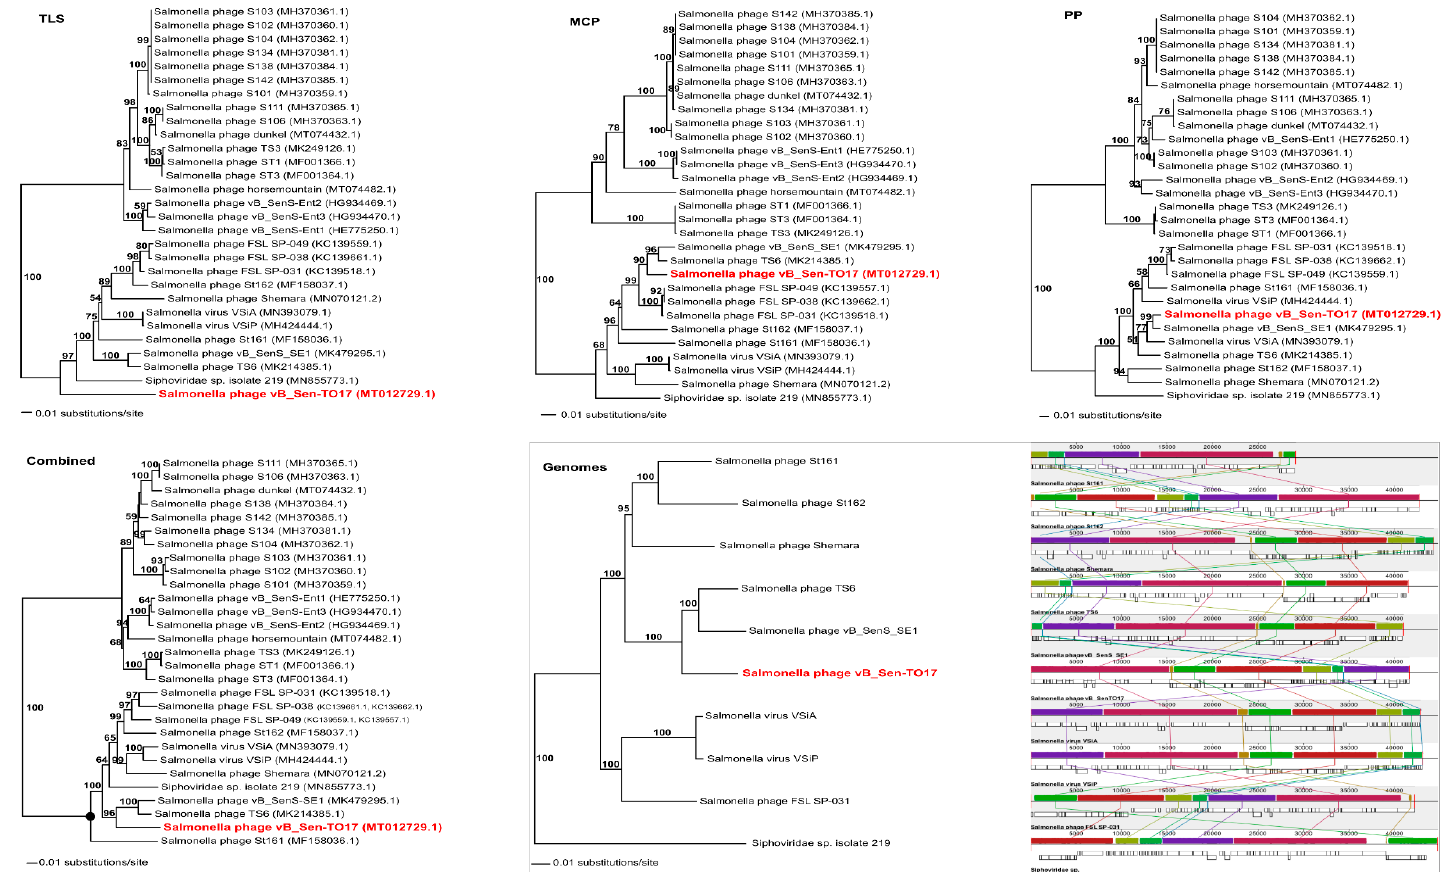
Figure 8. Neighbour-joining phylogenetic trees showing the phylogenetic position of phage vB_Sen-TO17 (in red color) within Cornellvirus based on the sequences coding for terminase large subunit (TLS), major capsid protein (MCP), portal protein (PP), their combined nucleotide sequences (Combined), as well as on the whole-genome analysis (Genomes). The reference sequences were collected from the NCBI database. The tree was constructed using PAUP *. Bootstrap value > 50%, calculated based on 1000 resamplings, is shown above the branches.